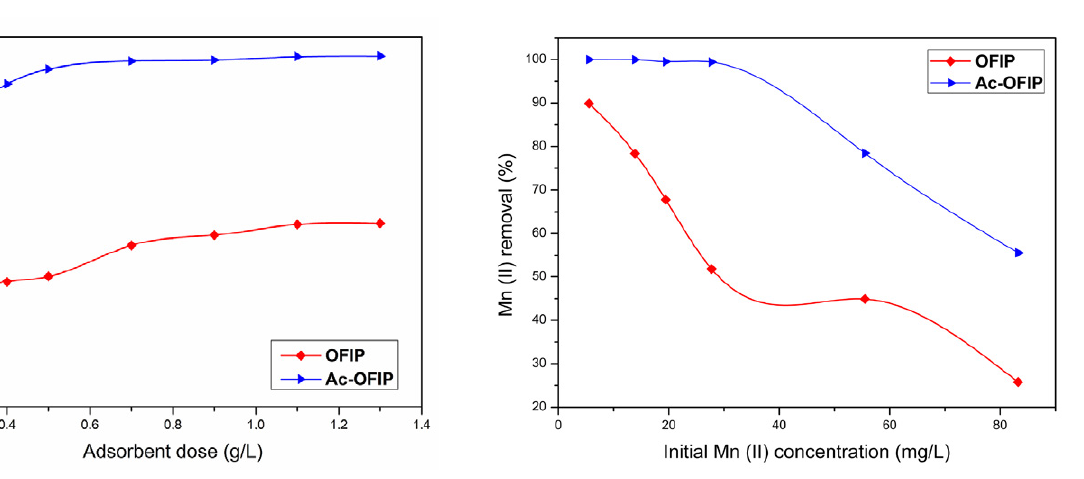
Fig. 5. Effect of Mn (II) concentration on removal rate for OFIP and